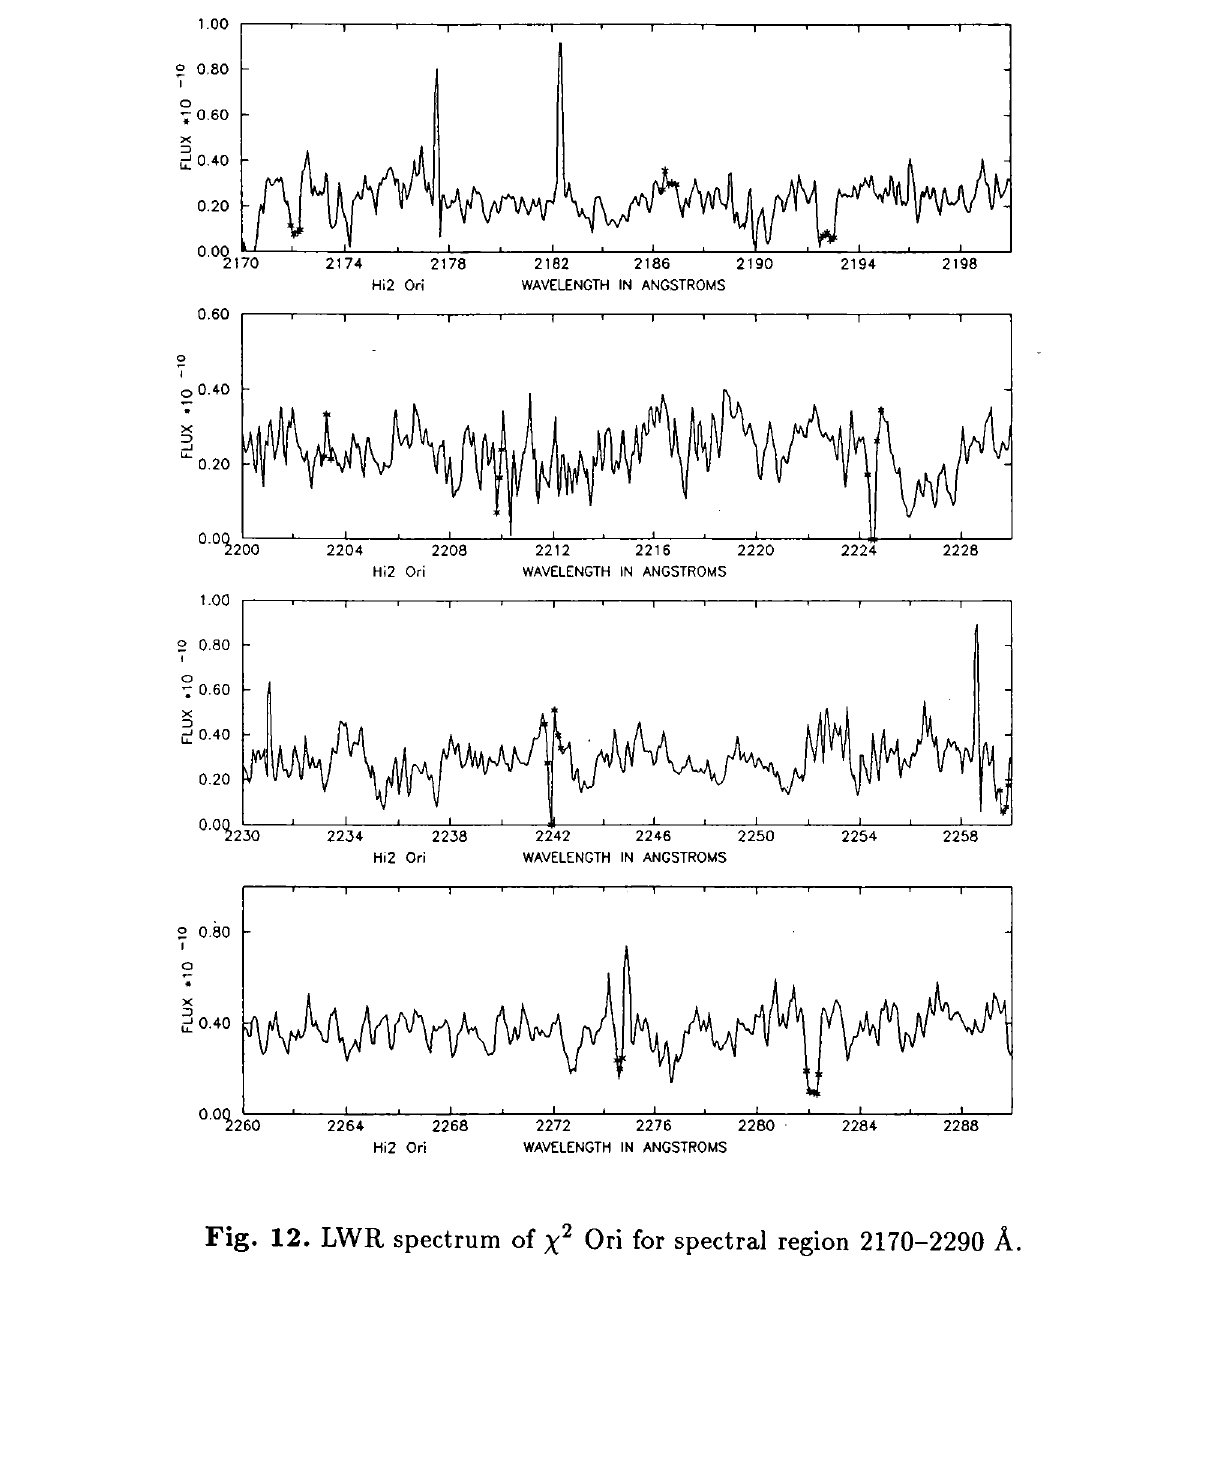
Fig. 12. LWR spectrum of \ 2 Ori for spectral region 2170-2290